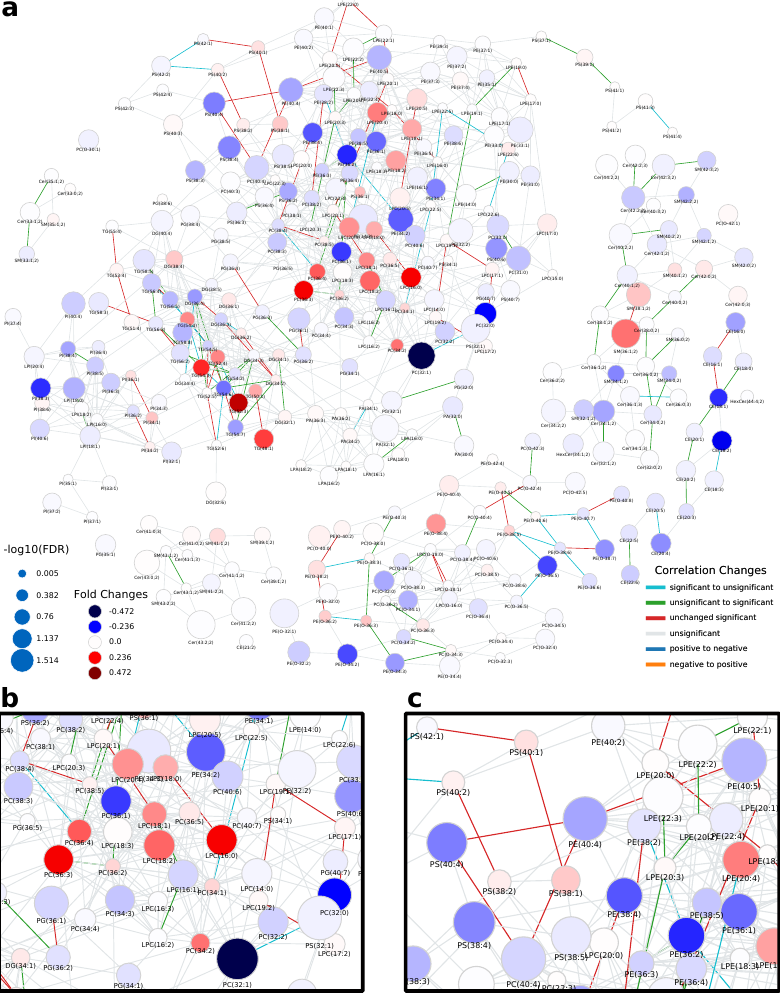
Figure 2. Lipid network of colorectal cancer lipidomics data from Wang et al. [16]. ( a ) Full lipid network with node size scaled by negative log10 of p -values for comparison between healthy and cancer tissue. Lipids are colored by log fold change between healthy and cancer tissue. Blue colors indicate lower levels of lipids in the healthy condition compared to the tumor and red higher levels in healthy samples. Edges are colored by changes of correlation for lipids from the healthy to cancer condition. For example, green indicates a non-statistically significant correlation in the healthy condition and a statistically significant correlation in the tumor, where the correlation has the same sign. ( b ) Subnetwork showing PC and LPC nodes. ( c ) Subnetwork showing mainly unsaturated